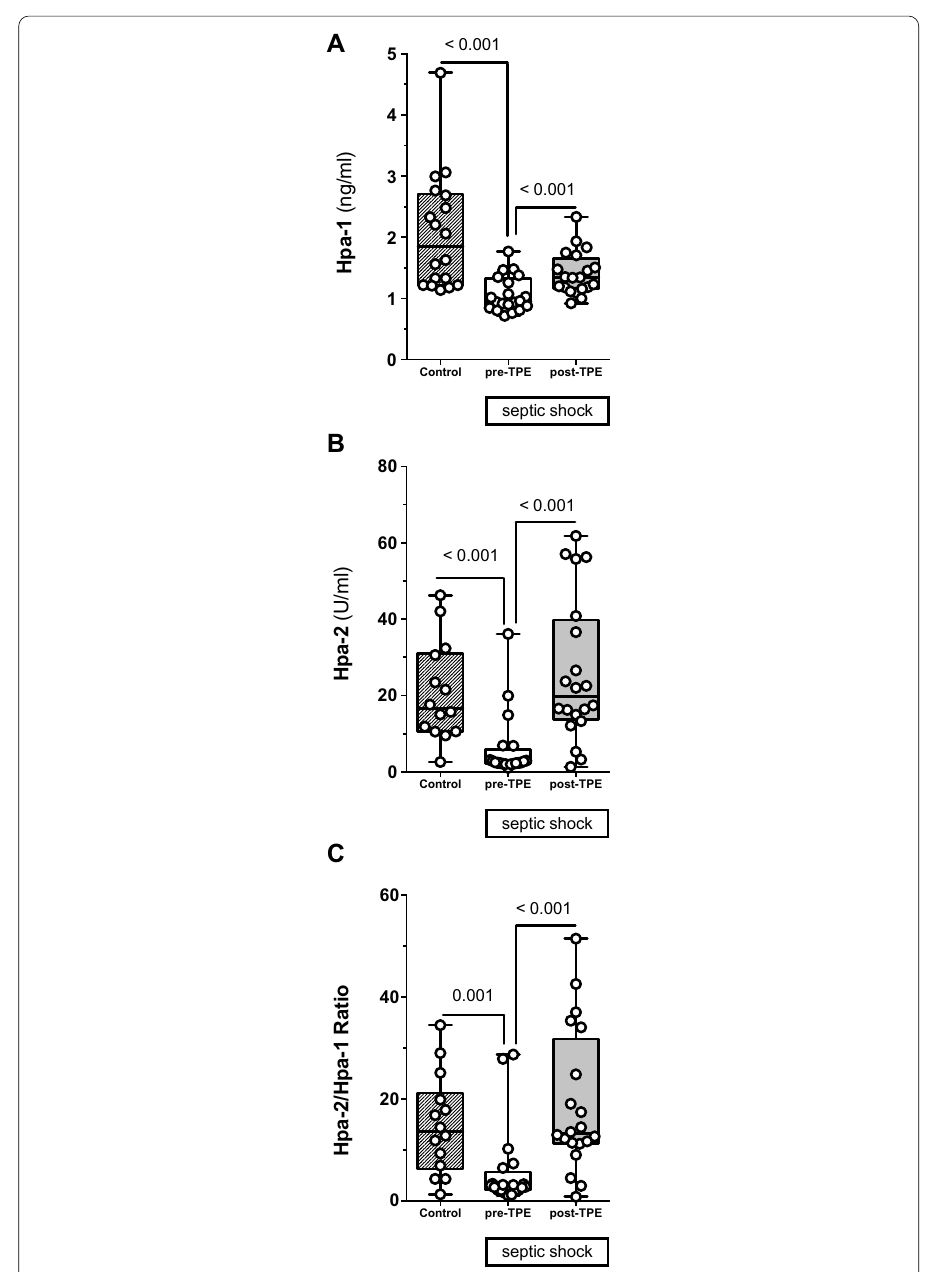
Fig. 4 Effect of therapeutic plasma exchange (TPE) on key regulating enzymes of the endothelial glycocalyx (eGC). Box and whisker plots showing blood concentrations of circulating Heparanase-1 (Hpa-1) ( A ), Heparanase-2 (Hpa-2) ( B ) as well as the ratio of Hpa-2 to Hpa-1 ( C ) for healthy controls ( n patients with septic shock before (pre) ( n